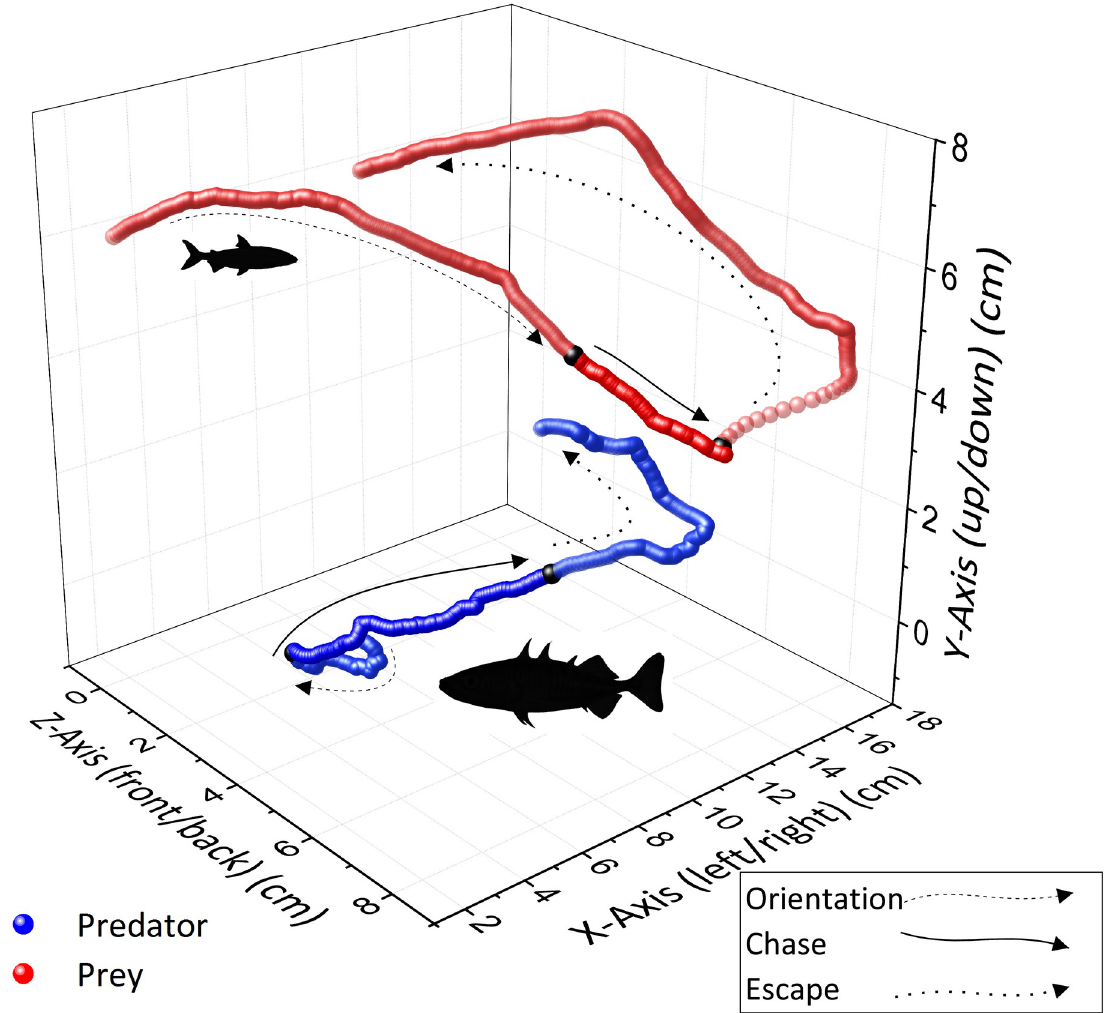
Fig 3. 3D analysis. Resulting data points of the 3D analysis were smoothed in Python 3. Depicted are different stages of a failed predation (stickleback: blue, whitefish: red). Tracking started 3 s before capture or escape (400 frames).